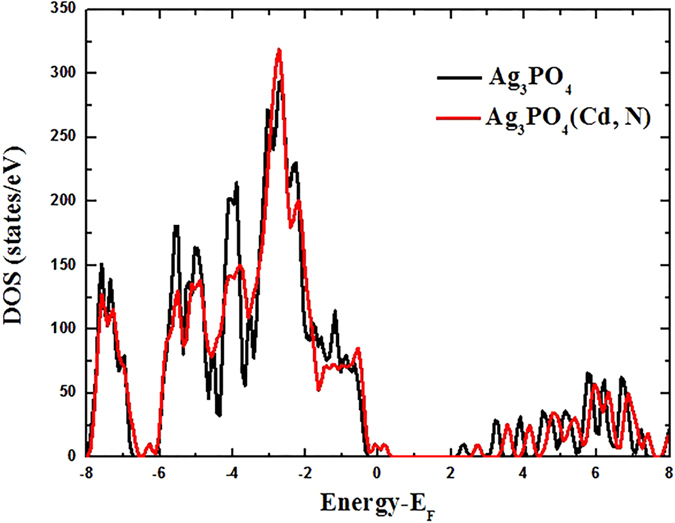
The calculated total DOS for pure Ag3PO4 and a supercell containing a (CdAg-NO) complex.